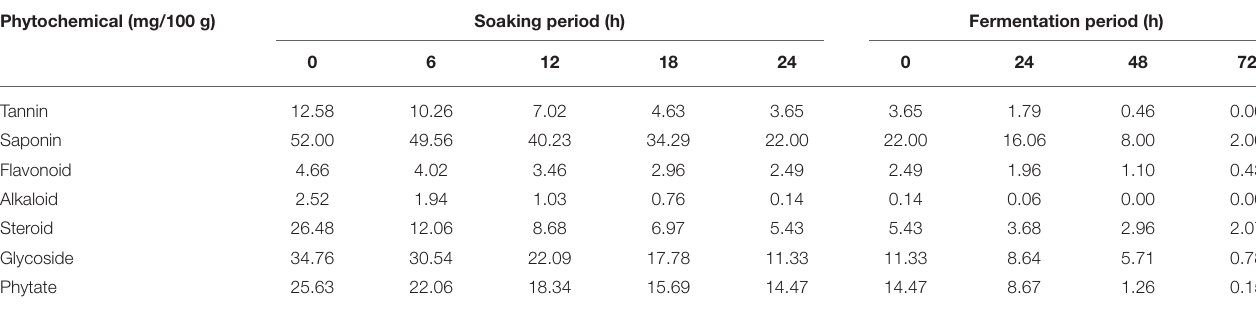
TABLE 7 | Effect of soaking and fermentation period on the anti-nutritional/phytochemical contents of African oil bean seed. Phytochemical (mg/100 g) Soaking period